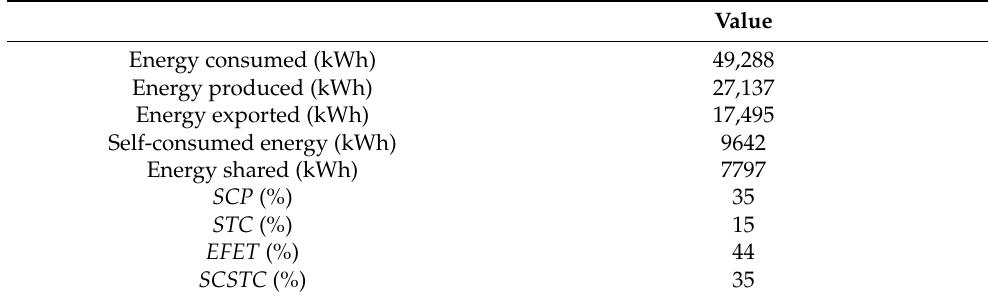
Table 4. Energy statistics and key performance indexes calculated for the period from March 2021 and February